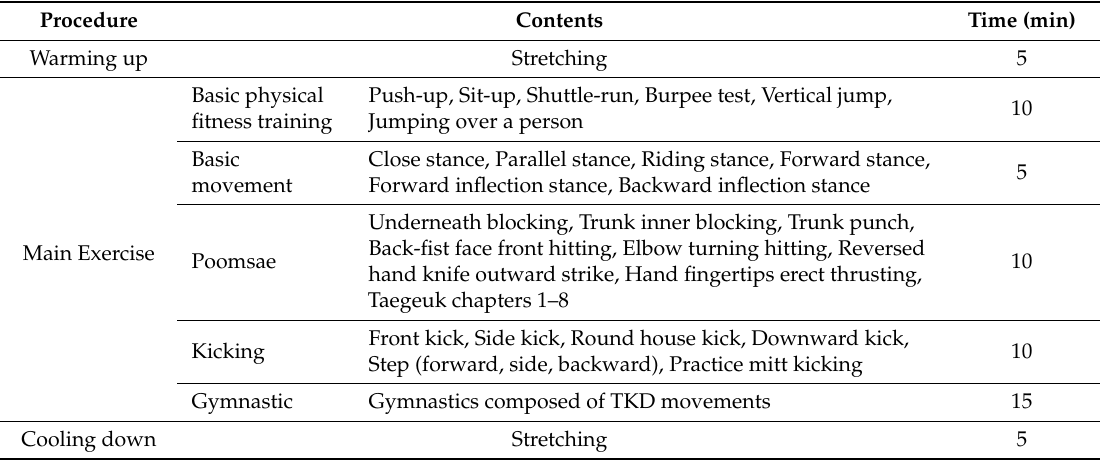
Table 2. TKD training